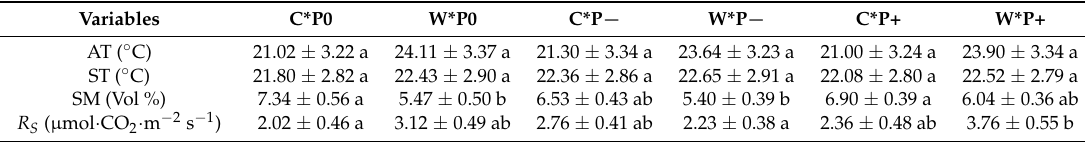
Table 2. Mean air temperature (AT), soil temperature (ST), soil moisture (SM), and soil respiration ( R S ) under different treatments, presented as mean ± standard